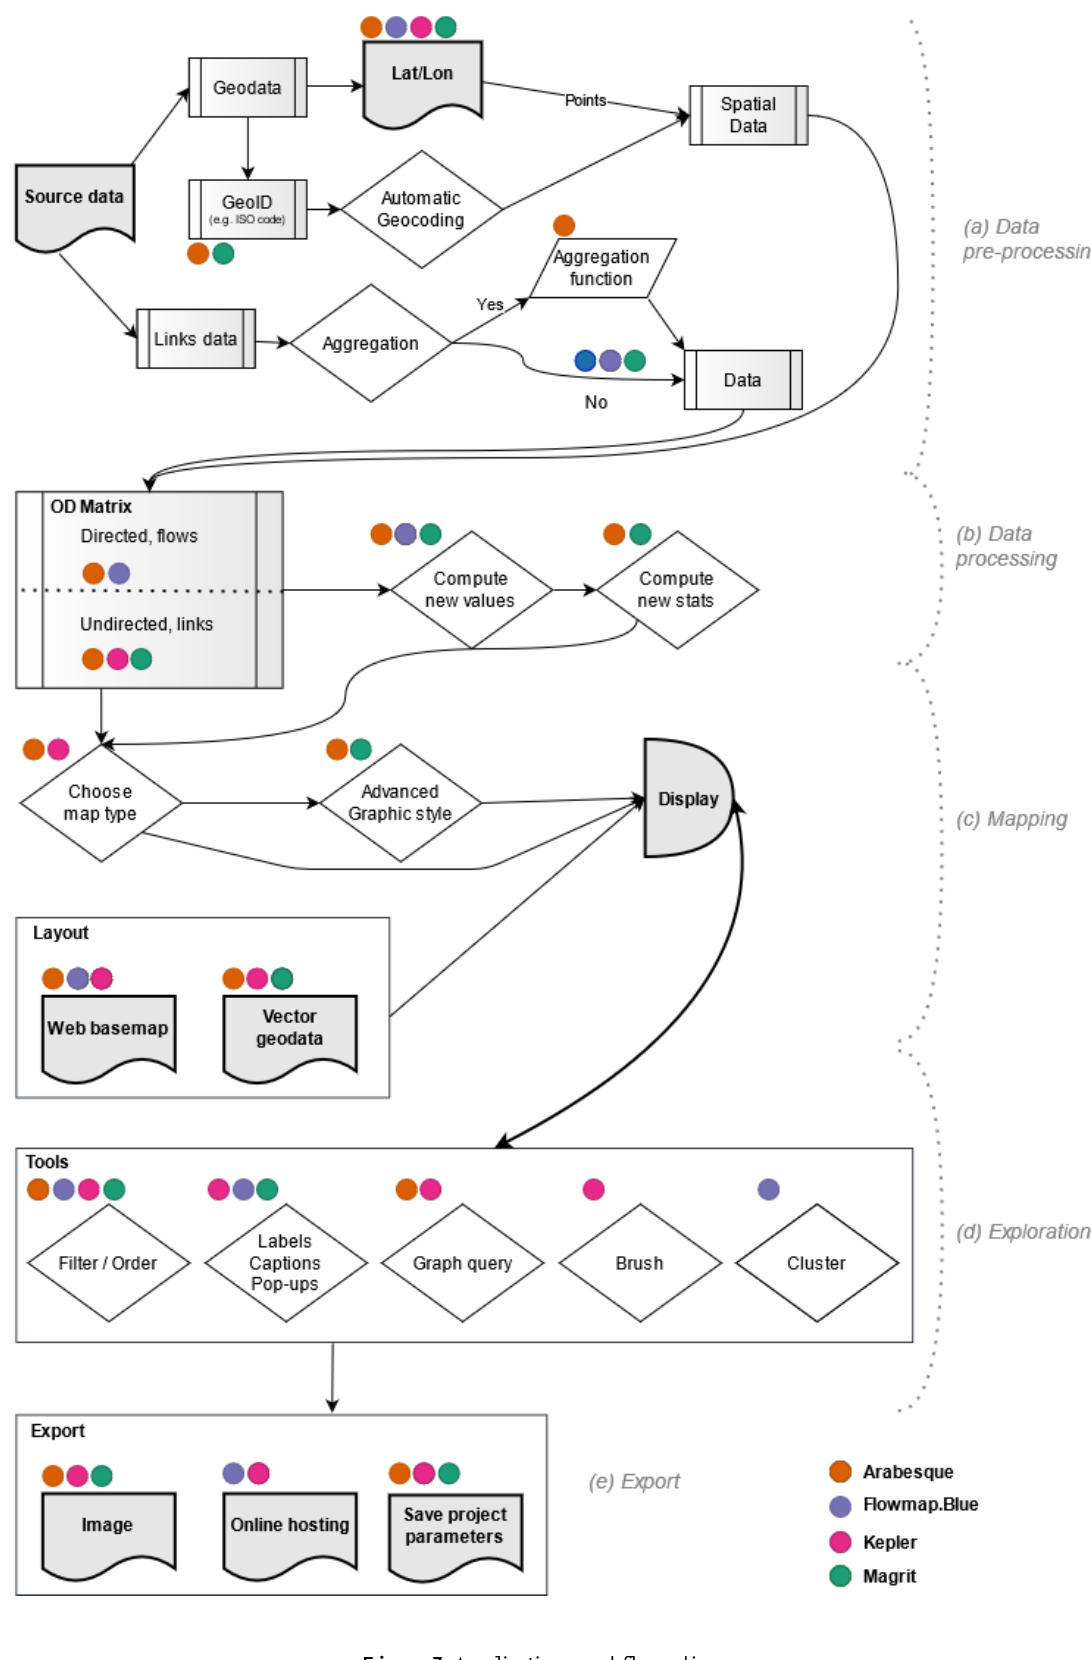
Figure 7 . Applications workflows